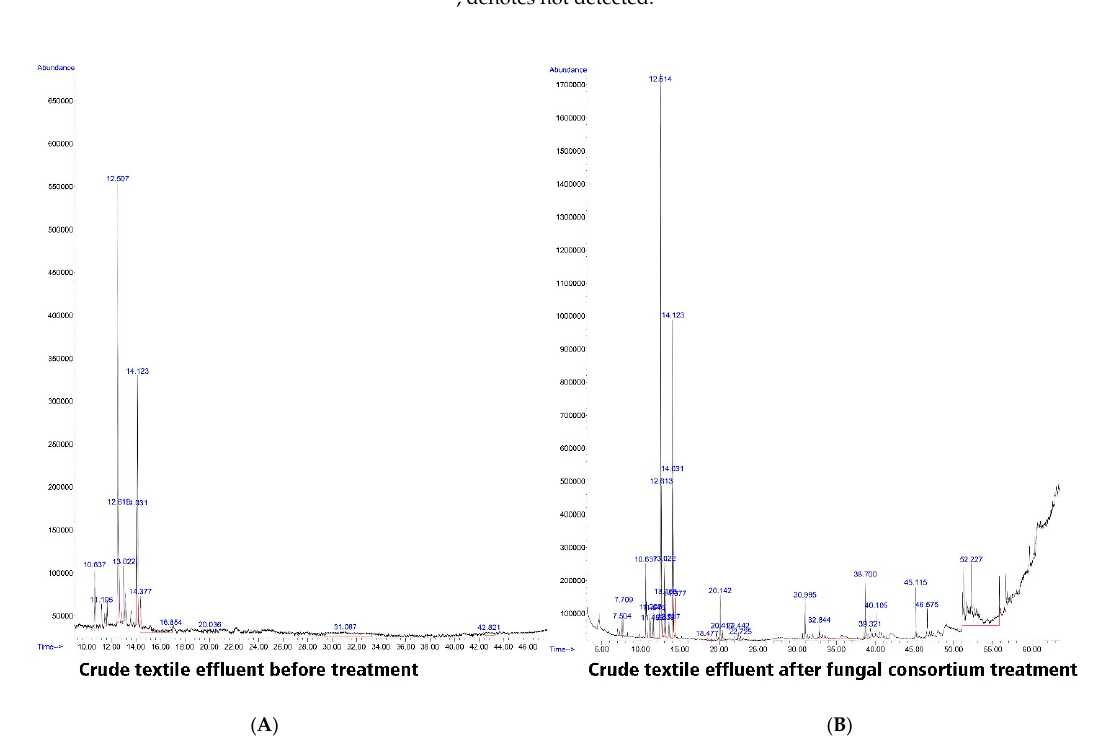
Figure 5. GC-mass spectra of textile wastewater before ( A ) and after ( B ) fungal consortium treatment.